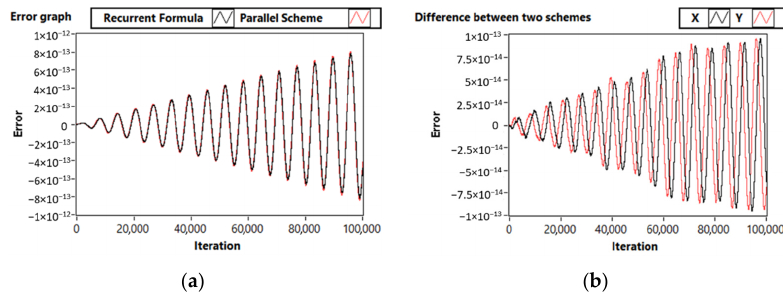
Figure 7. Absolute truncation error plots given relatively to the analytical solution for recurrent Runge–Kutta method and proposed parallel scheme ( a ). Difference between the truncation errors for parallel and serial solvers ( b ). Simulation time 100 s, step size value 0.001 s.